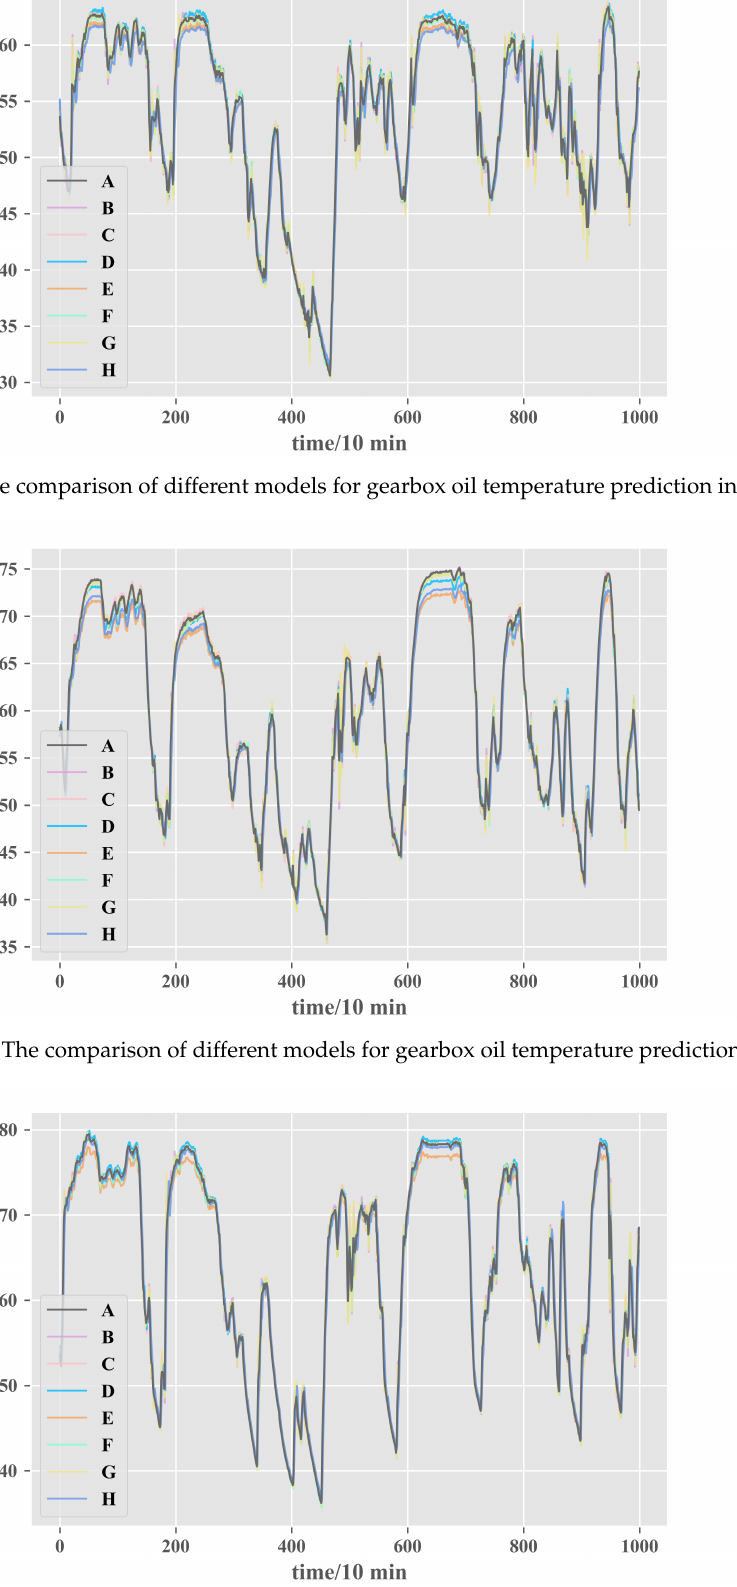
Figure 9. The comparison of different models for gearbox input shaft temperature prediction in